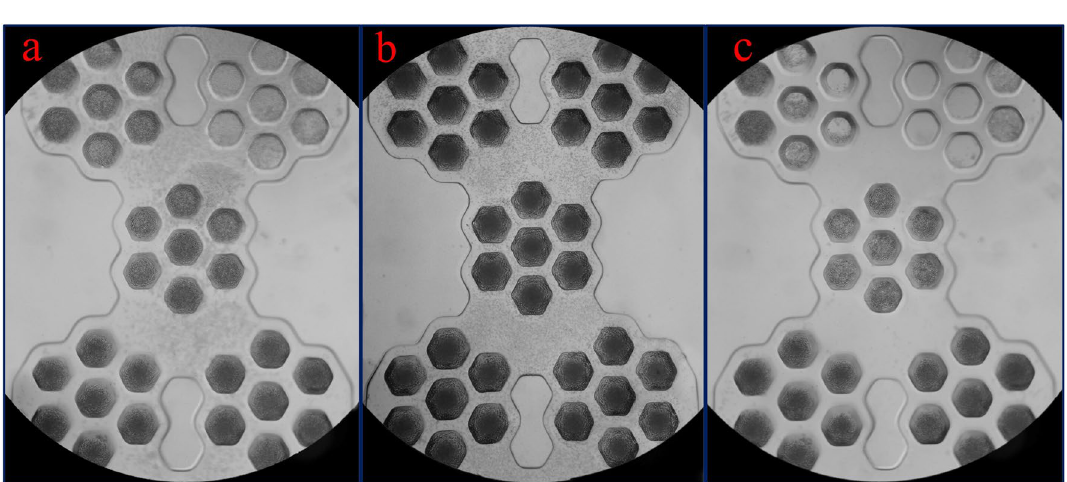
Figure 8. ( a ) The chip with variable depth microwells after cell injection. The difference in the depth of the microwells significantly influences for trapping cells. ( b ) The chip with constant depth (300 µm) microwells after cell injection. The density of trapped cells is uniform for all microwells. ( c ) Microwells after washing with the culture medium. Some microwells with a depth of 100 and 200 μm were emptied after